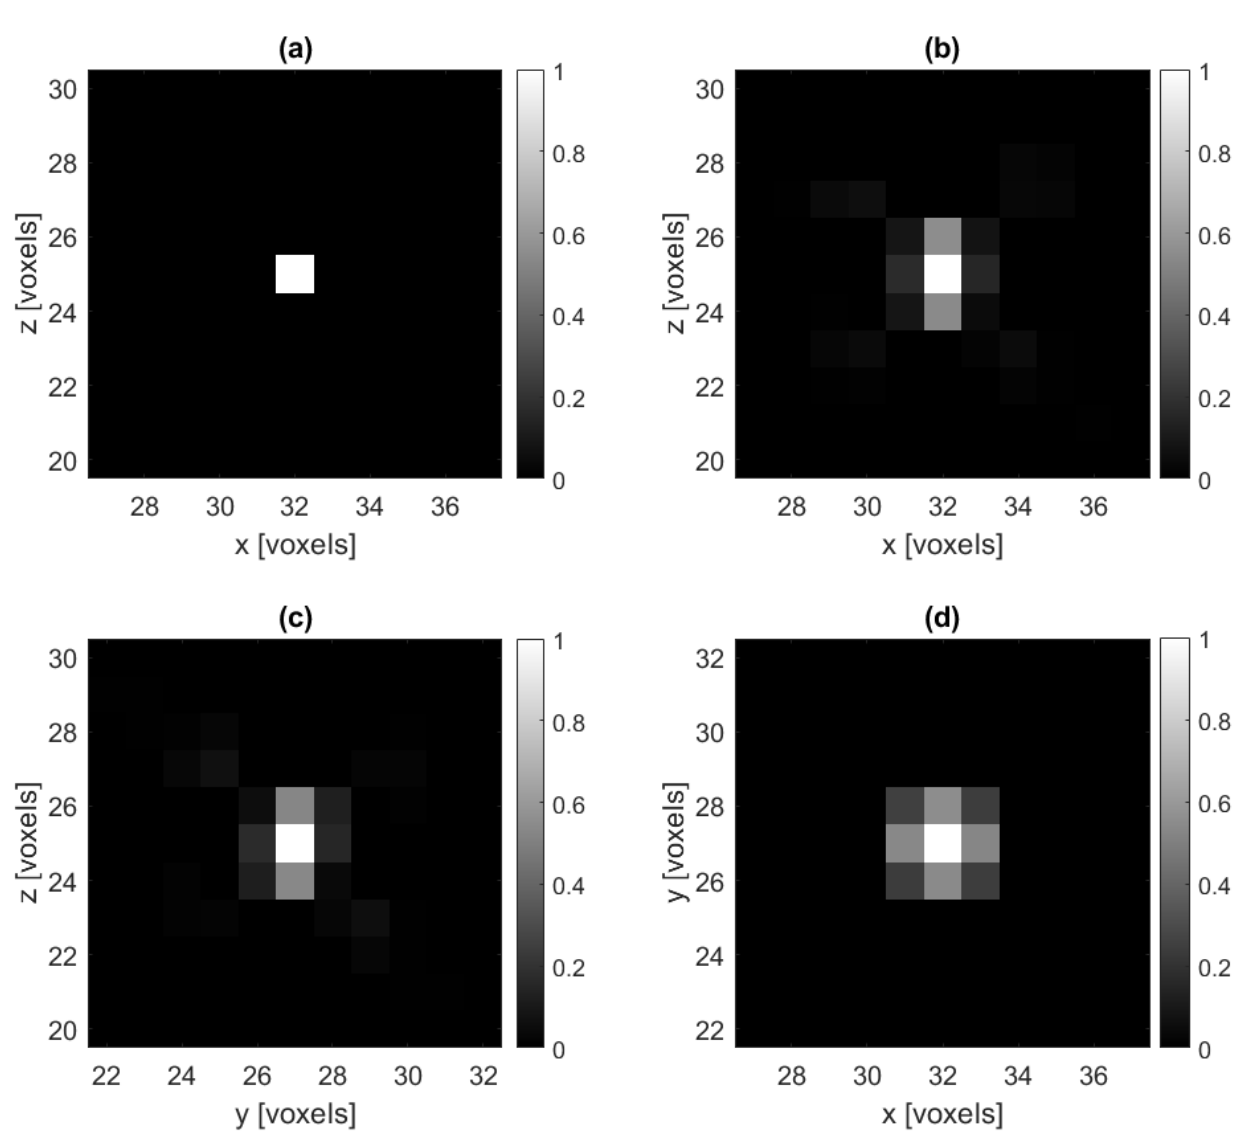
Figure 3. ( a ) A cross-section of the ground truth impulse IPD and ( b – d ) cross-sections of a no-noise reconstruction of the